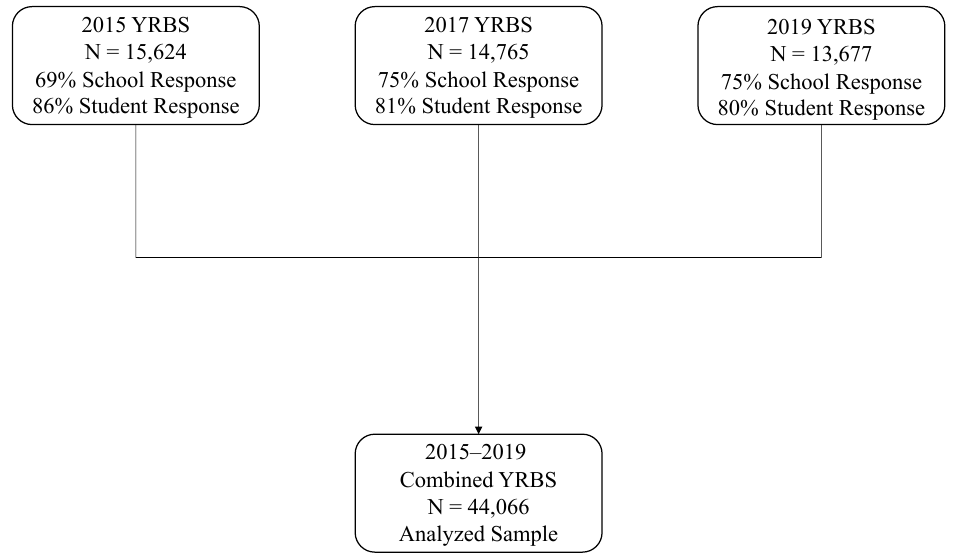
Figure 1. Flowchart showing the sample size, school response rate, and student response rate for the 2015, 2017, and 2019 US National Youth Risk Behavior